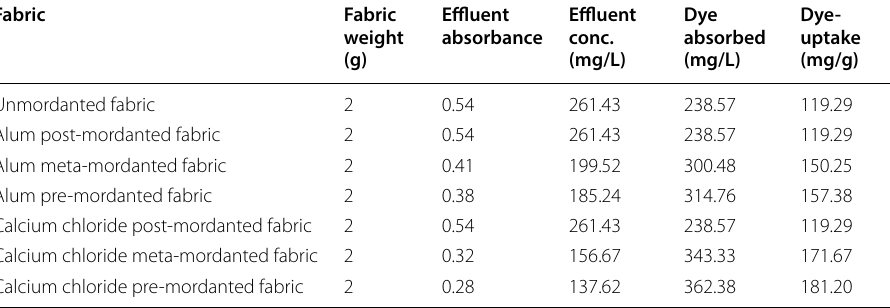
Table 2 Dye-uptake of unmordanted, alum and calcium chloride mordanted cotton fabrics